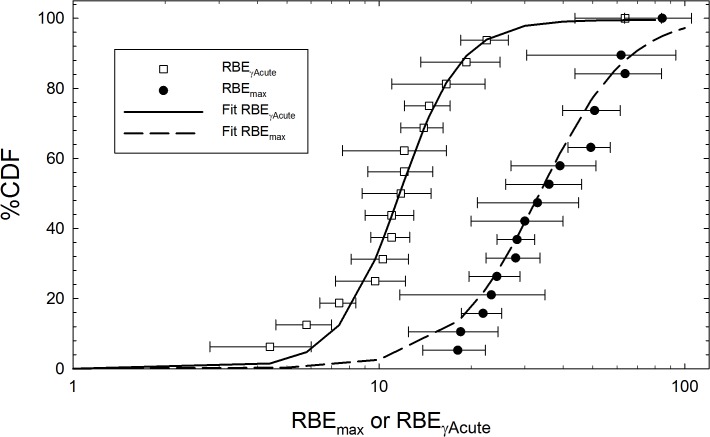
Cumulative distribution function (CDF) versus the maximum relative biological effectiveness (RBE) factor, RBEmax or RBEγAcute based on experimental data from Table 2, and non-linear regression fits of the 3 parameter logistic equation to these data.